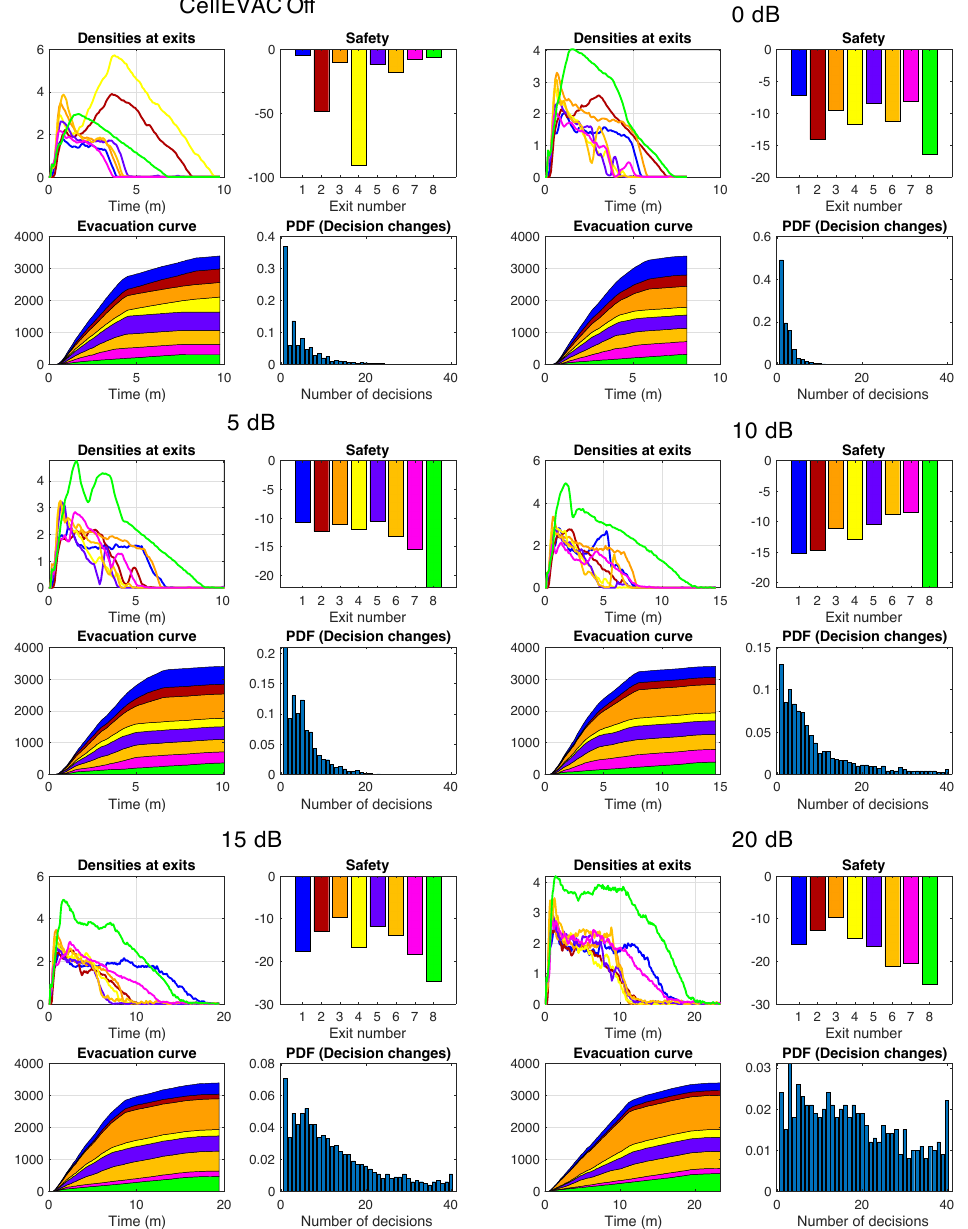
Figure 10. Results of single run simulations with external flows in evacuation scenarios in which pedestrians do not use CellEVAC (CellEVAC Off), and in evacuation scenarios using CellEVAC and assuming positioning errors from 0 to 20 dB. Each subfigure shows the evolution of density, safety values and evacuation curves at each exit gate, and the histogram (probability density function) of the number of decision changes of the pedestrians. Colors identify the different exit gates, as described in the Madrid Arena